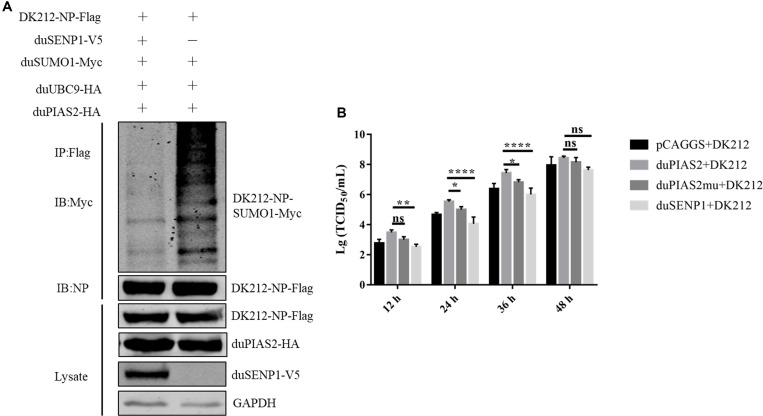
The SUMO E3 activity of duPIAS2 is necessary to promote DK212 replication. (A) duSENP1 inhibited the SUMOylation of DK212 NP promoted by duPIAS2. HEK 293T cells were transfected with pCAGGS-DK212-NP-Flag, SUMOylation-related expression plasmids, and pCAGGS-duSENP1-V5. After 36 h, the transfected cells were lysed and immunoprecipitated with anti-Flag agarose beads. (B) DEF cells were transfected with pCAGGS-duPIAS2-HA, pCAGGS-duPIAS2mu-HA, pCAGGS-duSENP1-V5, or pCAGGS. At 24 h post-transfection, the cells were infected with 100 TCID50 of DK212. The culture supernatants were harvested for measurement of their viral TCID50 at 12, 24, 36, and 48 h post-infection, respectively. The experiment was repeated three times. The error bars represent the means and SDs (n = 3) and are compared using two-way ANOVA. nsP > 0.05, *P < 0.05; **P < 0.01; ****P < 0.0001.